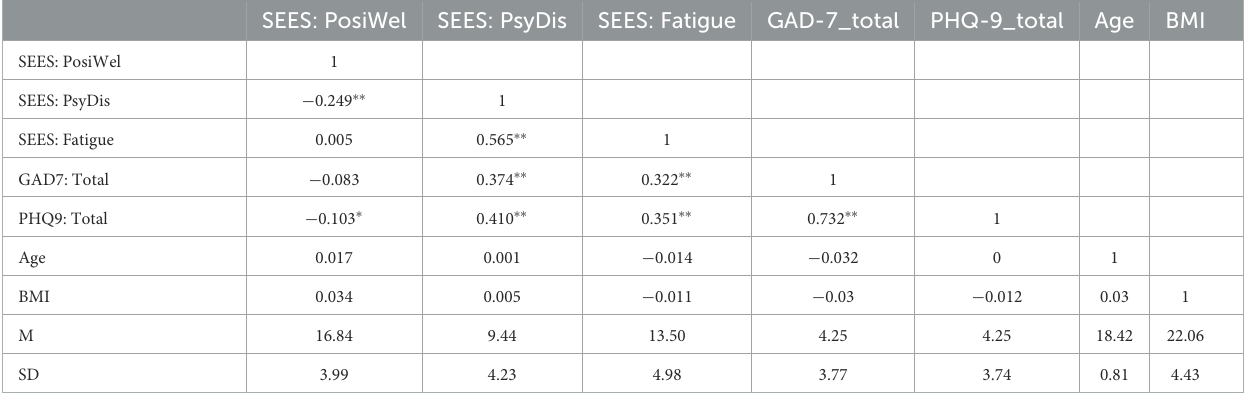
TABLE 2 Means, standard deviations, and correlations of